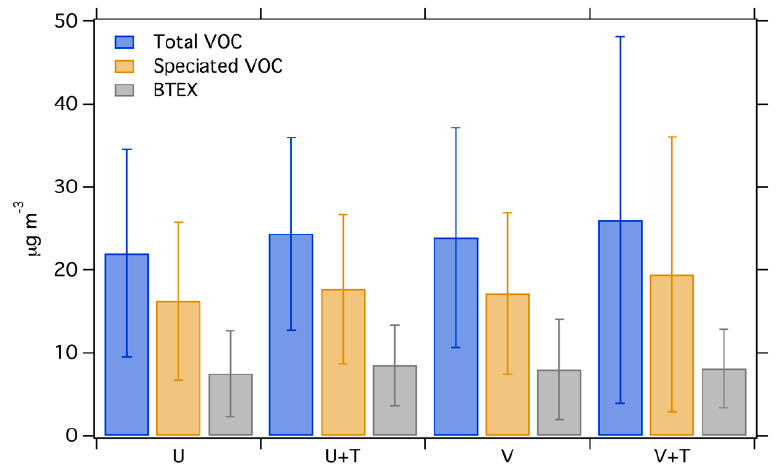
Figure 5. The average concentration of total VOC, speciated VOC and BTEX for each type of site when classified by land use. Error bars show one standard deviation.